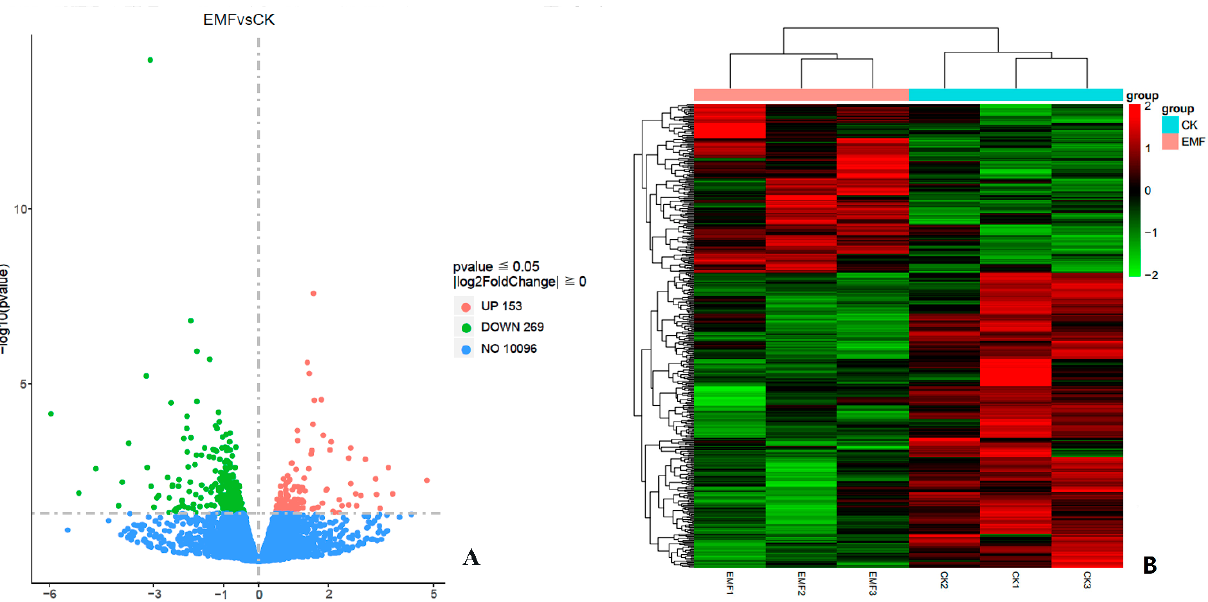
Figure 4. Volcano plot ( A ) and hierarchical clustering ( B ) of differentially expressed unigenes (DEGs) in honeybee larvae from EMF groups and CK groups. The expression level for each unigene was shown in the volcano plot. Up, up-regulated; Down, downregulated. X -axis shows fold change of the gene between EMF and CK groups. Y -axis means Log10 of unigene. The significant DEGs were considered as fold change ≥ 1 and FDR ≤ 0.05. Clustering analysis of DEGs showed that their expression mode in the three control samples could be clustered in one branch, while that in the three ELF-EMF exposed samples could be clustered in another branch. The similar expression profiles of DEGs in the three samples of both EMF group and CK group implied the good repeatability of the test.